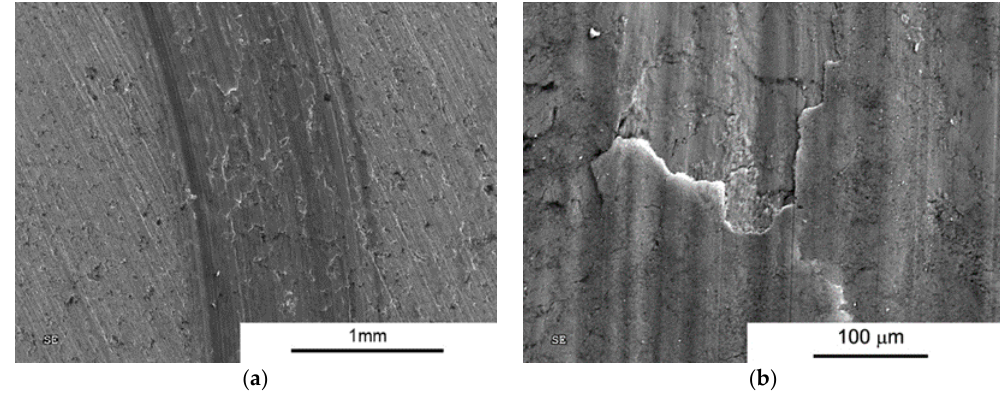
Figure 20. Worn Surface morphology for AA 6061 + 15 vol % MLG—load 10N SPT. ( a ) Wear trace image; and ( b ) close-up view.